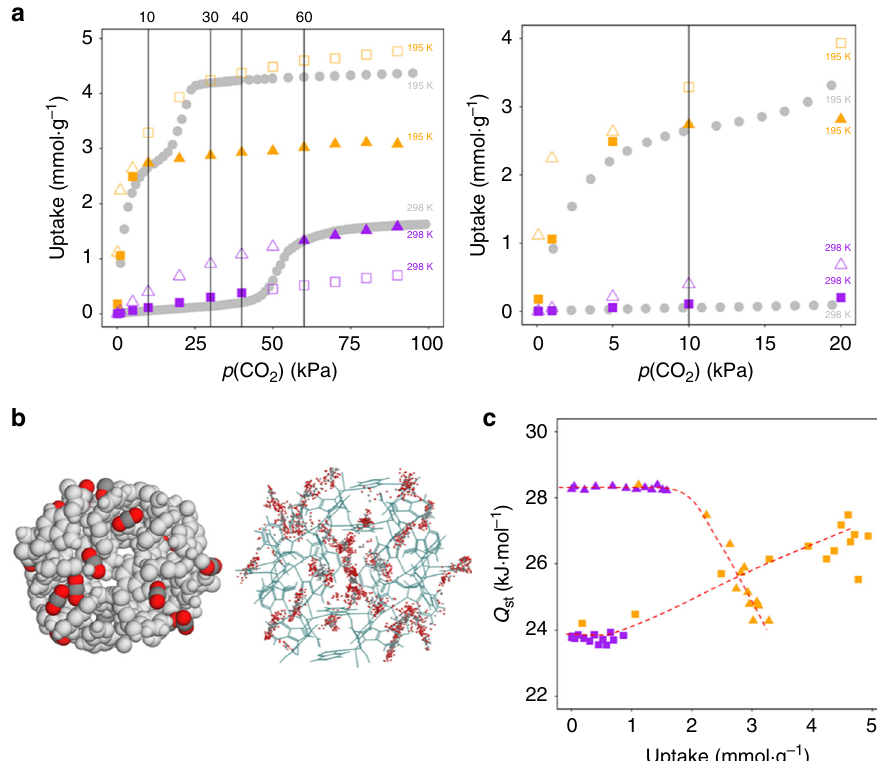
Fig. 4 GCMC simulations. a CO 2 adsorption isotherms of ZIF-7. Left: a comparison of experimental (gray circles) and simulated adsorption isotherms, using ZIF-7-I (triangles) and ZIF-7-II (squares) structures at 195 (orange) and 298 K (purple). Right: a detailed comparison at low pressure. Solid triangles and squares in the simulated isotherms correspond to the phases observed in the experimental isotherms. The vertical lines highlight the range of pressures at which the phase transitions occur: 10 – 30 kPa at 195 K and 40 – 60 kPa at 298 K. b Snapshot (left) and density distribution (right) of adsorbed CO 2 molecules in ZIF-7-II at 10 kPa and 195 K. c Heat of adsorption of CO 2 in ZIF-7-I (triangles) and ZIF-7-II (squares) at 195 (orange) and 298 K (purple). Red dotted lines are included as